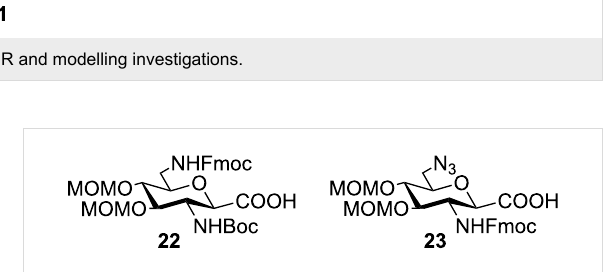
Figure 10: Protected derivatives of 2,6-diamino-2,6-dideoxy- β -D-gluc- opyranosyl carboxylic acid 22 and 23 .